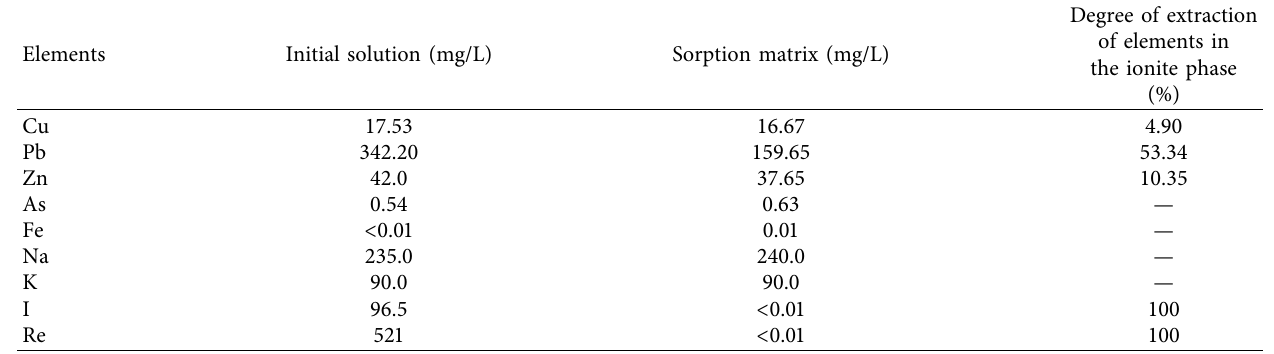
Table 4: Distribution of elements in the sorption process.